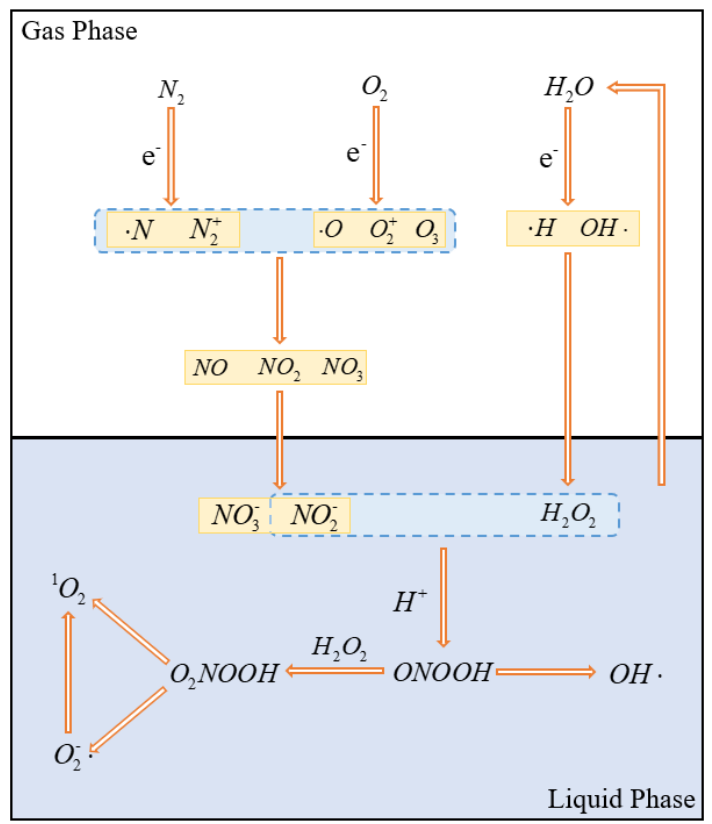
Figure 13. Generation pathways of major aqueous RONS in PATW.